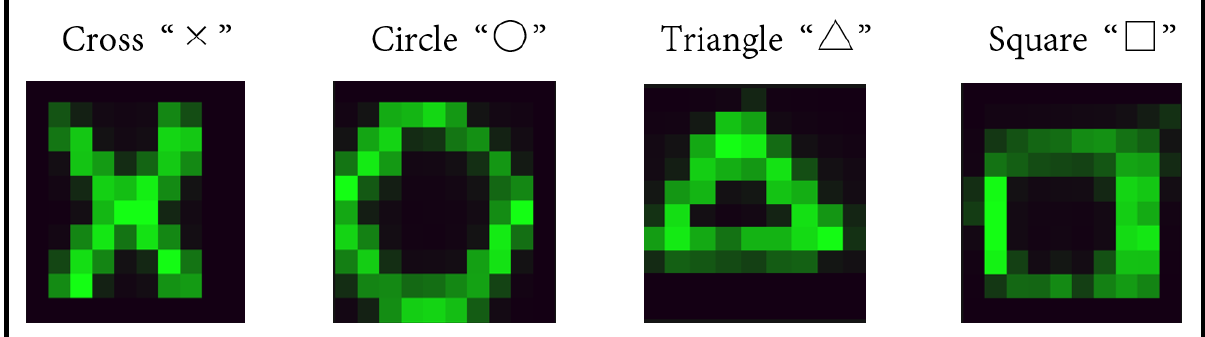
Figure 12. Output of sensor for each line angle.